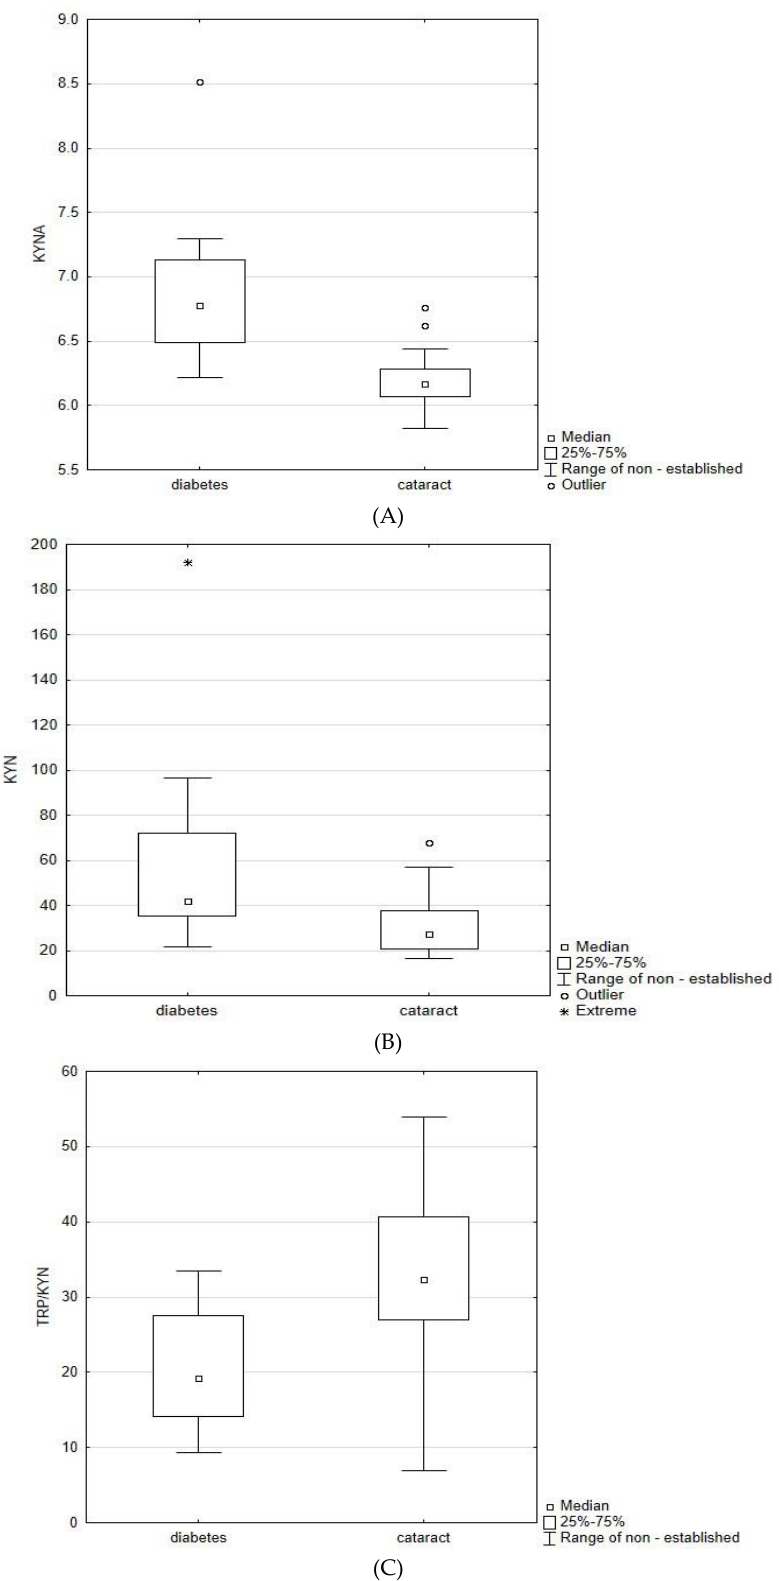
Figure 2. The box-plots representing statistically significant differences between the levels of KYNA ( A ), KYN ( B ) and ratio TRP/KYN ( C ) in patients with both studied groups. The concentrations of KYN and KYNA were significantly higher in patients with diabetes in comparison to cataracts alone. There were no differences in concentration of TRP and other